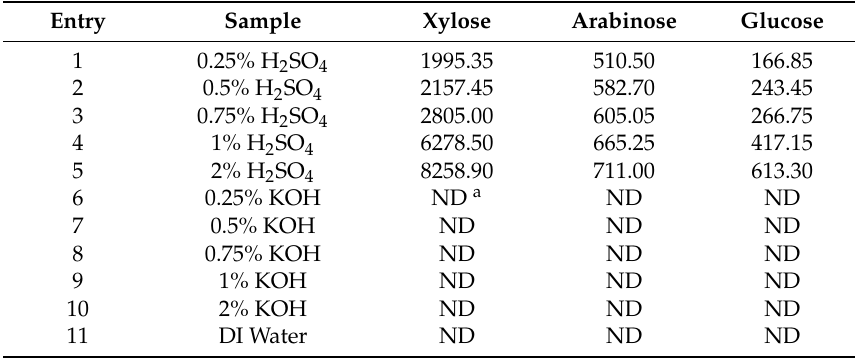
Table 1. Concentrations of major sugars in bamboo hydrolysates (mg/L).